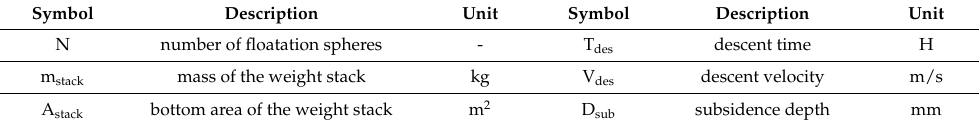
Table 4. Nomenclature.